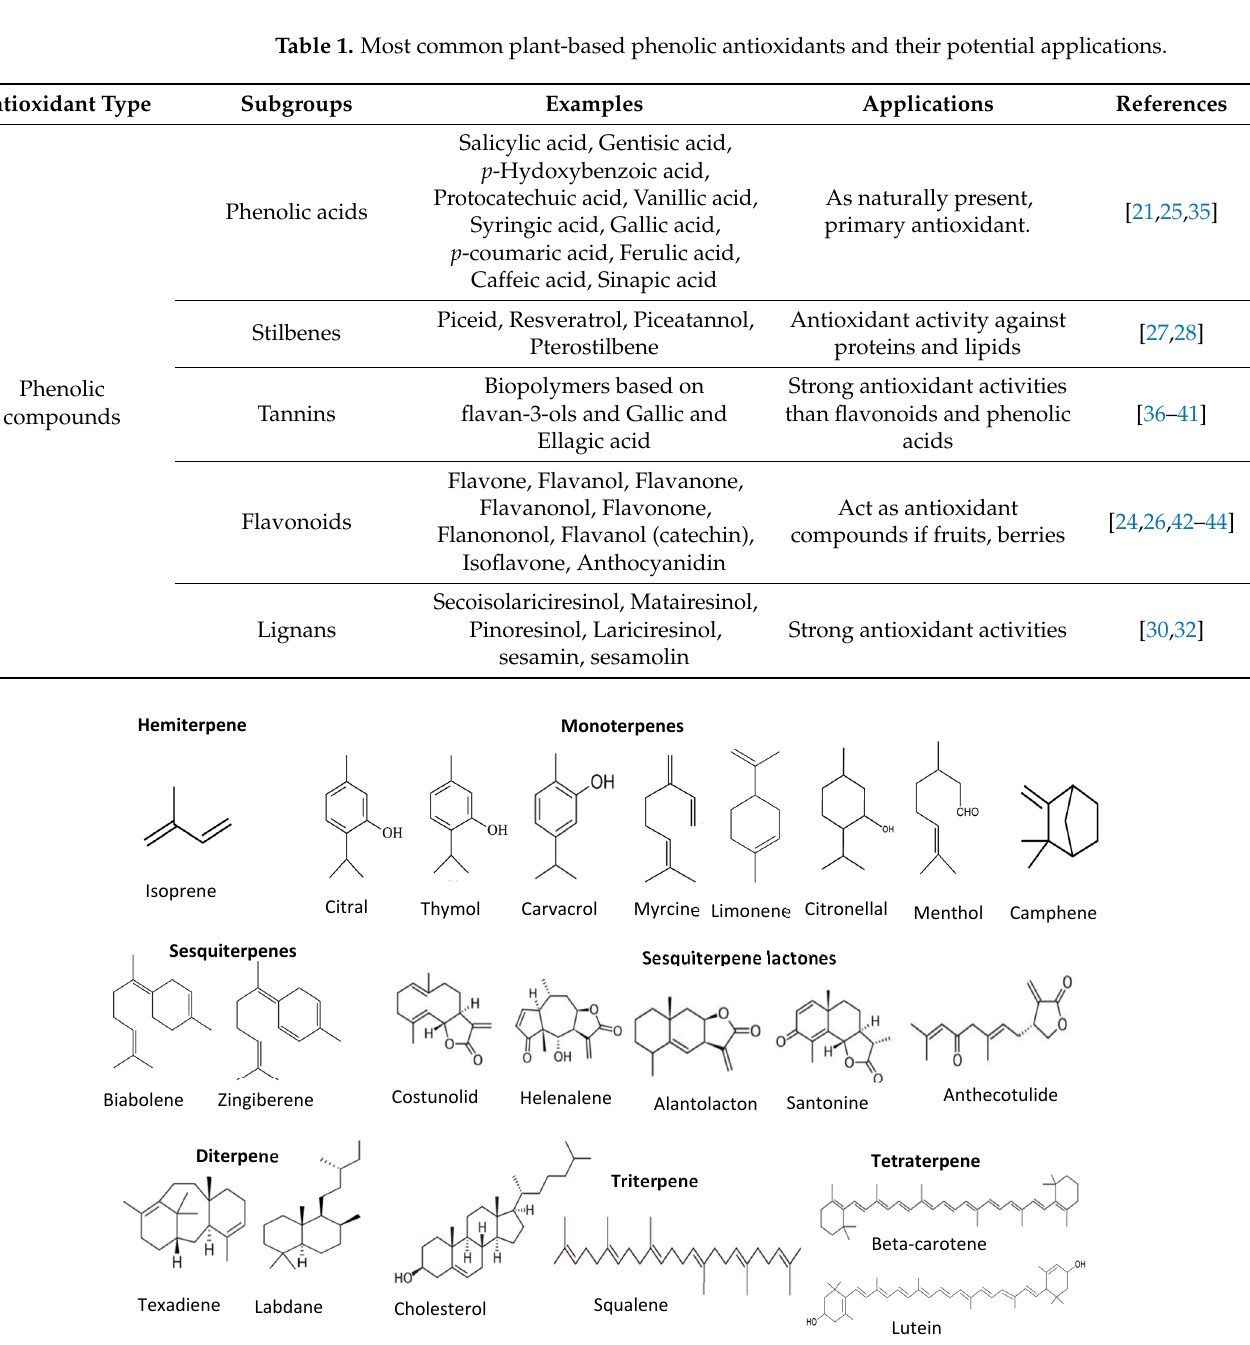
Figure 6. Structure of different classes of terpenoids. Tannins are another group of phenolic antioxidants in plants and can be divided into two main sub-classes: condensed tannins and hydrolyzable tannins. The condensed tannins are biopolymers based on flavan-3-ols, and gallic and ellagic acid derivatives (gal- lotannins and ellagitannins) are the main components with antioxidant properties [36,39]. Gallotannins are natural polymers formed by the esterification of D-glucose and gallic acid hydroxyl groups. Proanthocyanidins can donate hydrogen atoms/electrons and act as